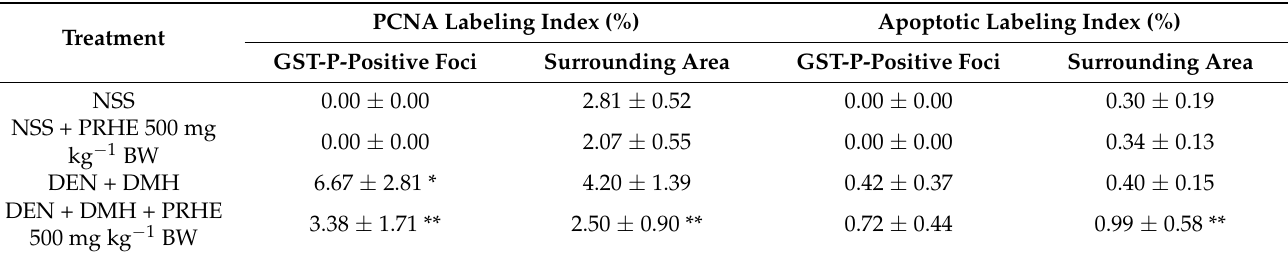
Table 3. Proliferating cell nuclear antigen (PCNA) and apoptotic labeling indices in GST-P-positive foci of